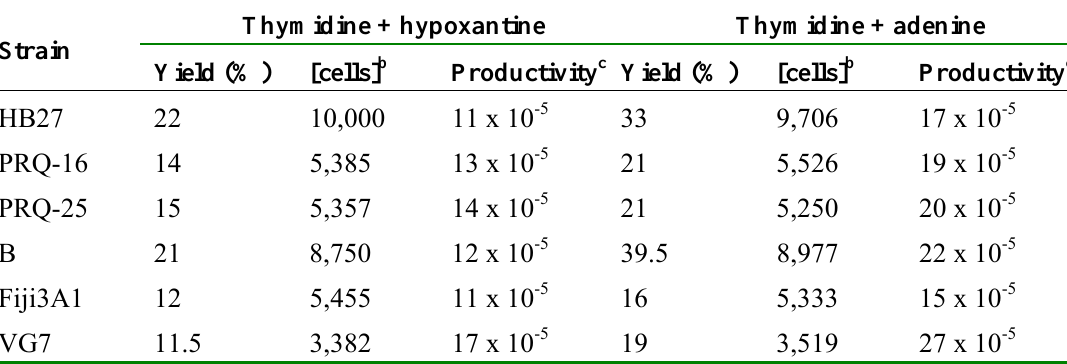
Table 3. Yield and productivity of the reaction thymidine + adenine or hypoxanthine a . Thymidine + Strain